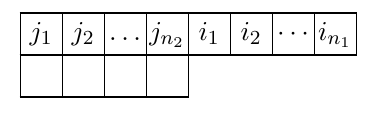
Figure 1 . Young tableau of SU(3)